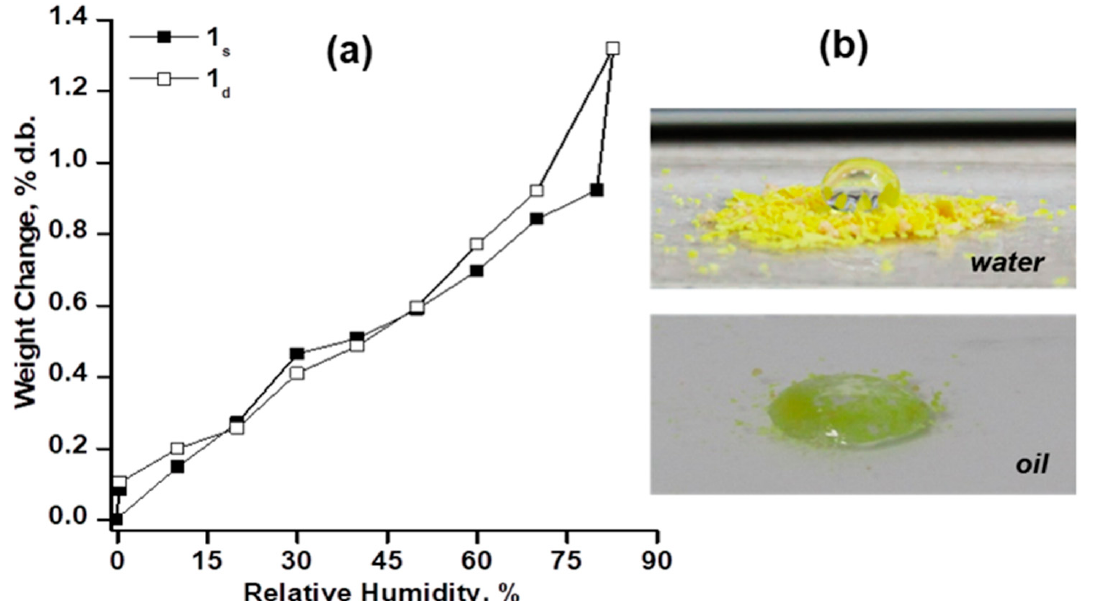
Figure 6. The moisture sorption–desorption isotherms for compound 1 , where the s and d subscript coefficients represent the sorption and desorption isotherms ( a ). Optical images of the water and oil droplets on compound 1 indicating hydrophobic behavior ( b ).